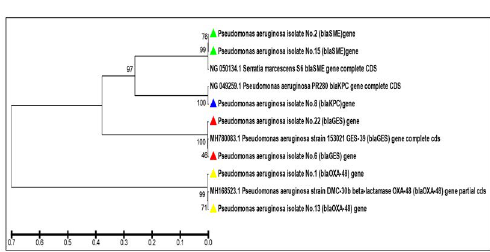
Fig. 7. The phylogenetic tree based on the partial gene sequencing of the serine carbapenemase genes in the resistant P. aeruginosa isolates to